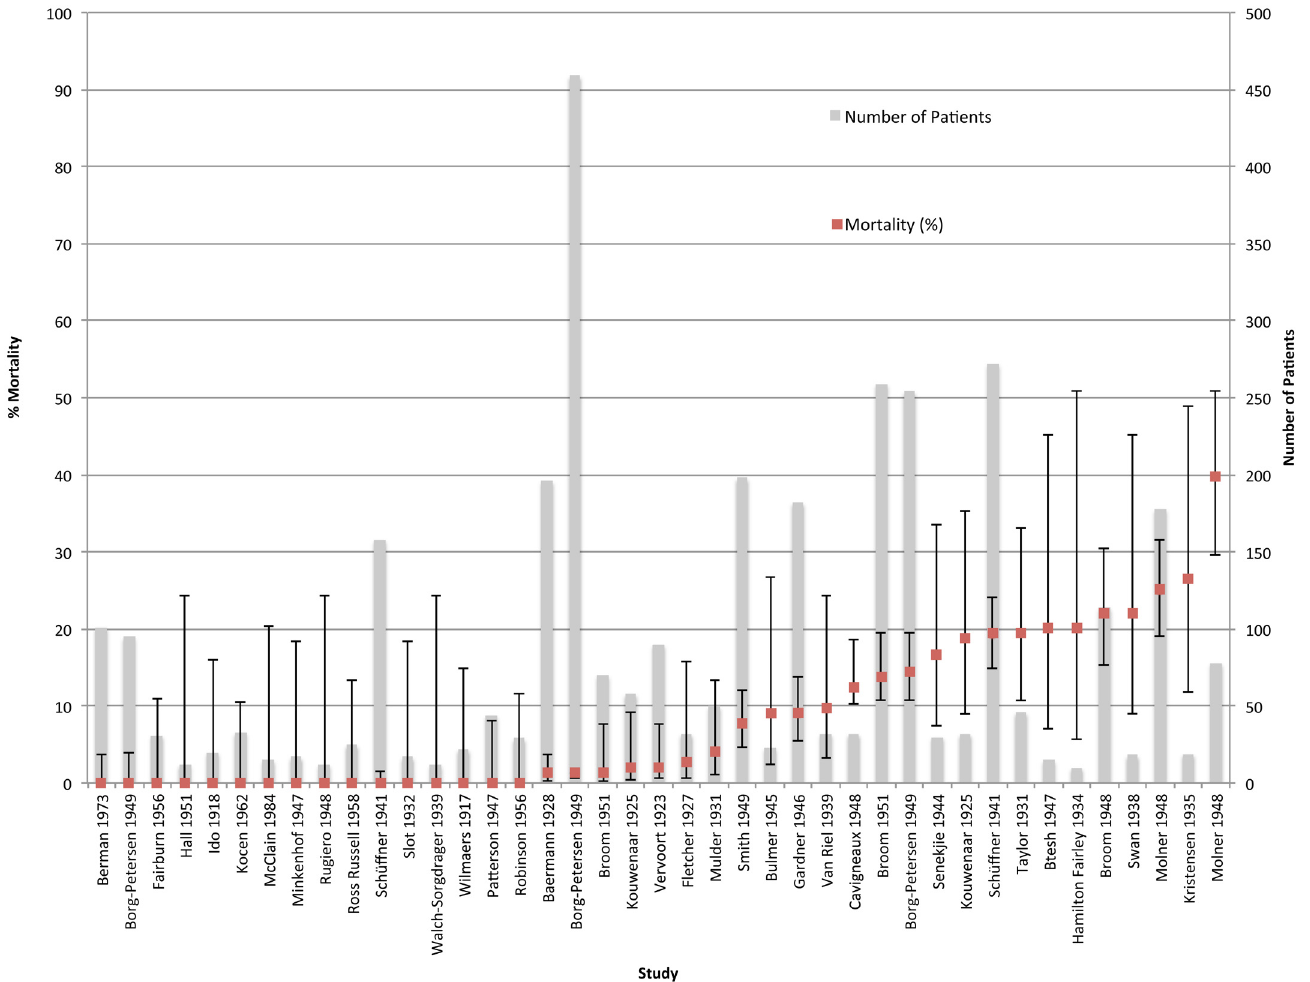
Fig 3. Mortality (%) (red line) and sample size (grey column) in order of increasing series mortality. 95% confidence intervals are estimated using the Wilson score interval